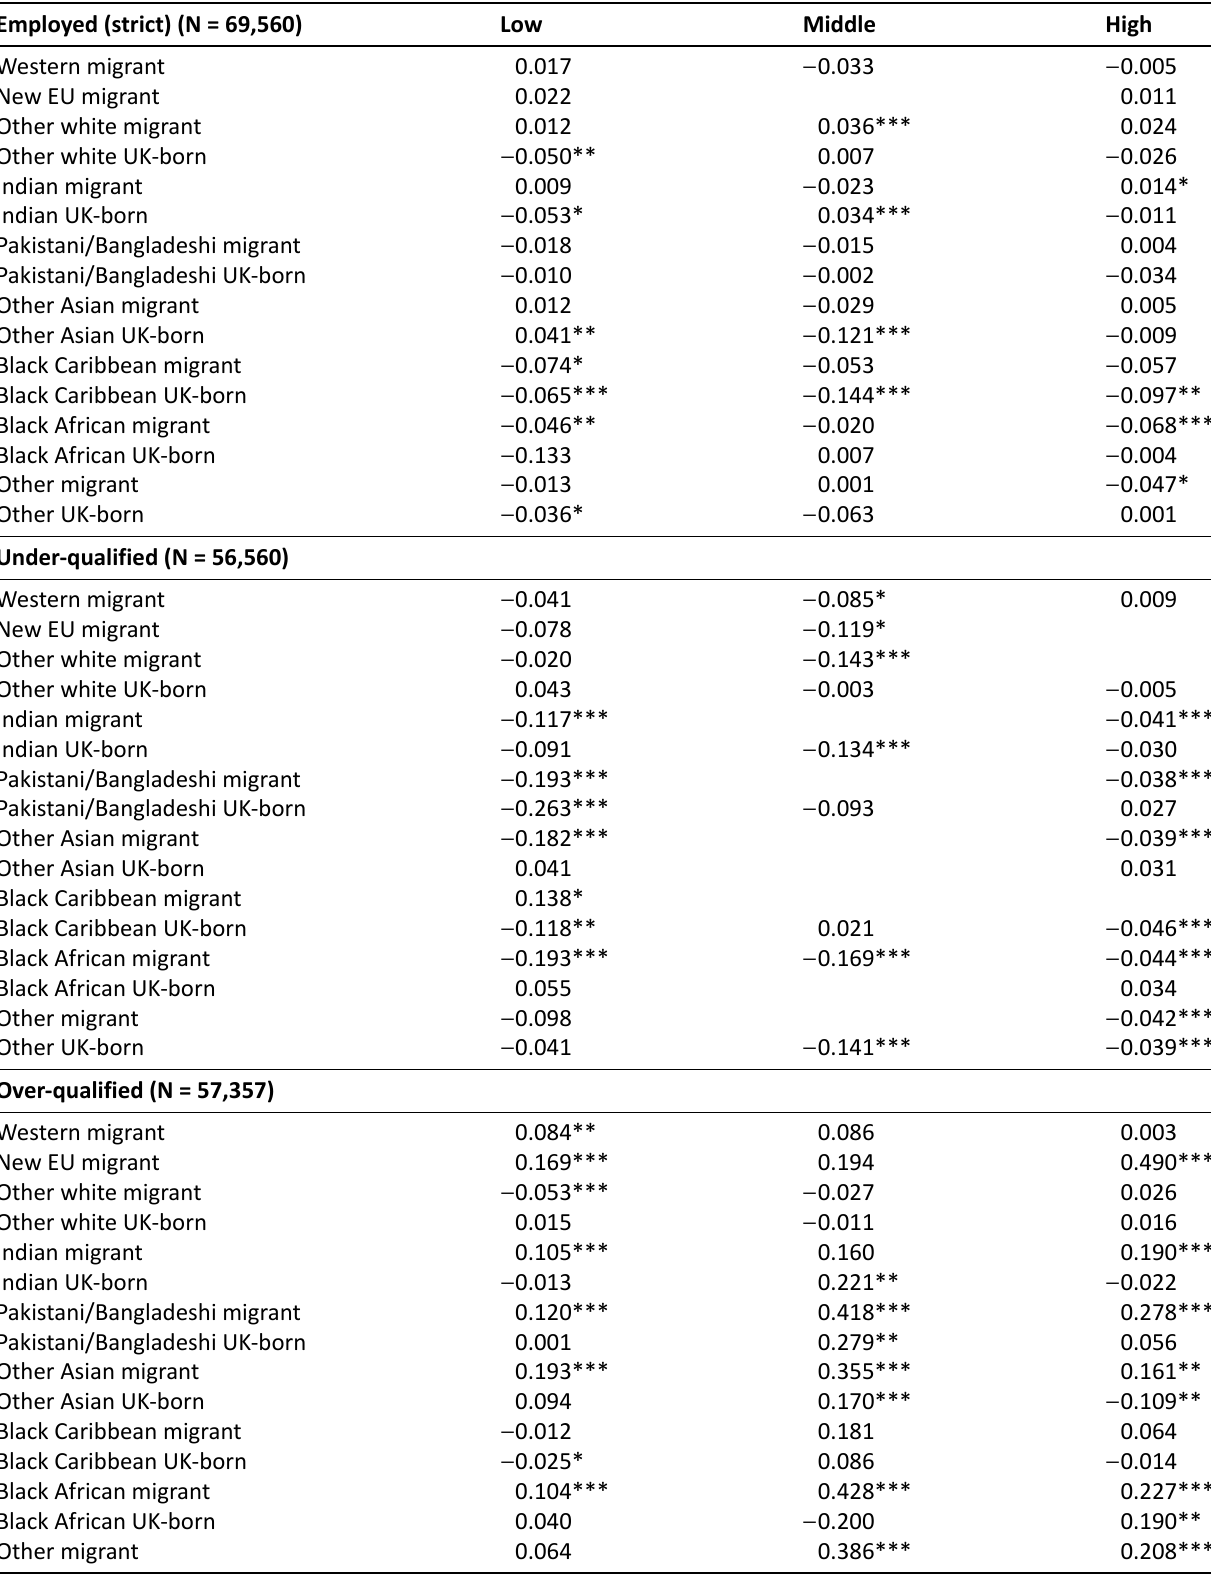
Table A8. Robustness tests for men: binary logistic regression of being employed rather than unemployed, and under- and over-qualification using